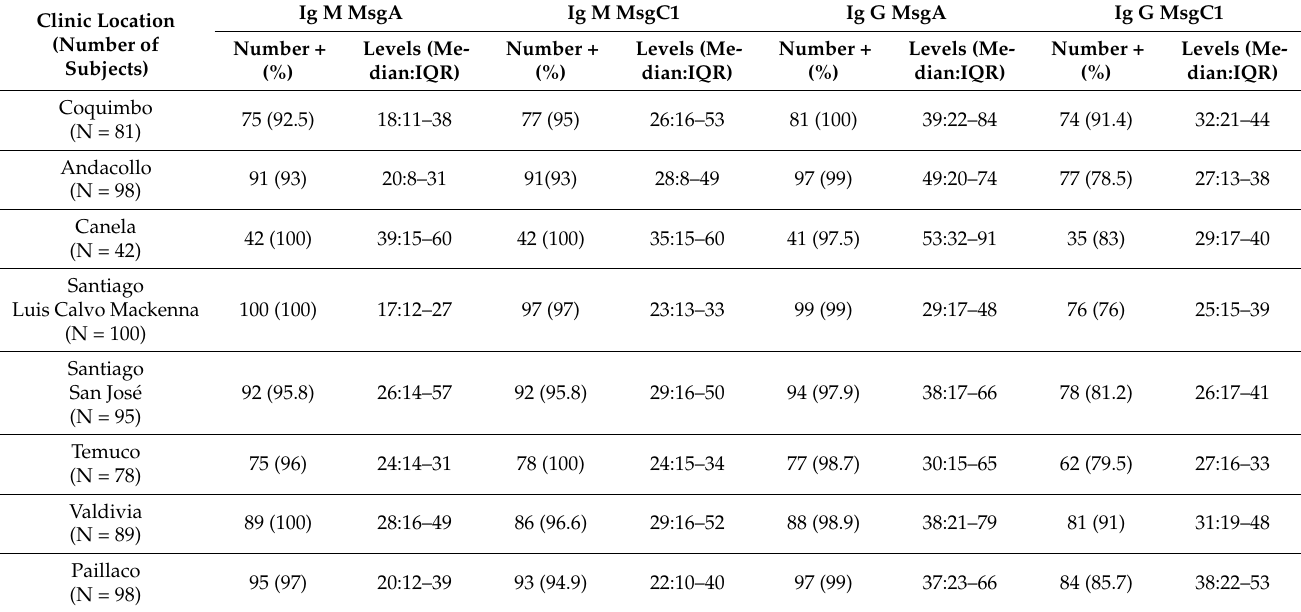
Table 2. Ig M and Ig G antibody responses to Pneumocystis MsgA and MsgC1 constructs in